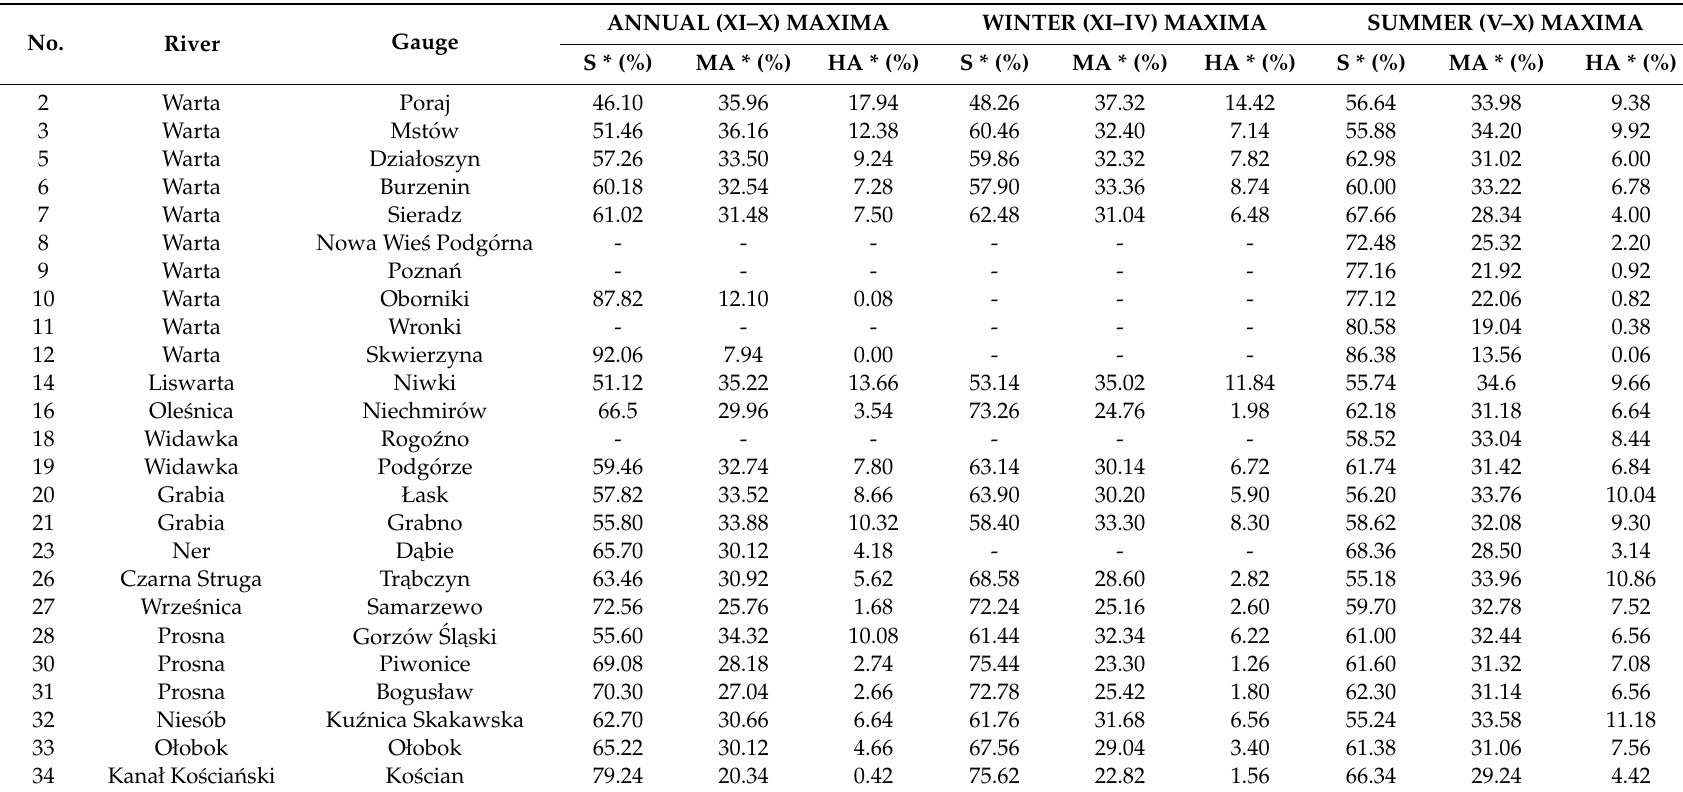
Table A2. The percent share of the synchronous and asynchronous occurrences of the annual (AMAXq), winter (WMAXq), and summer (SMAXq) maximum specific runo ff s in respective gauges in relation to the Gorz ó w Wielkopolski gauge closing the Warta River catchment (WRC) (numbering of the gauges in accordance with Figure